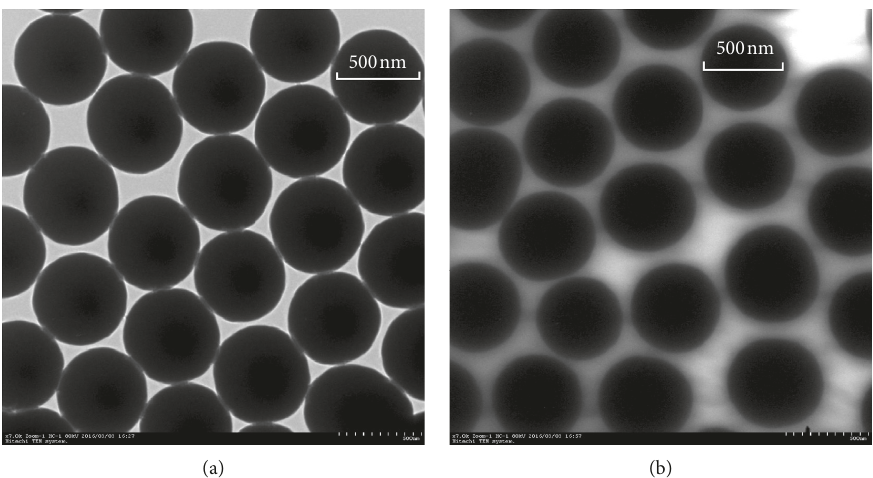
Figure 5: The TEM images of (a) SiO